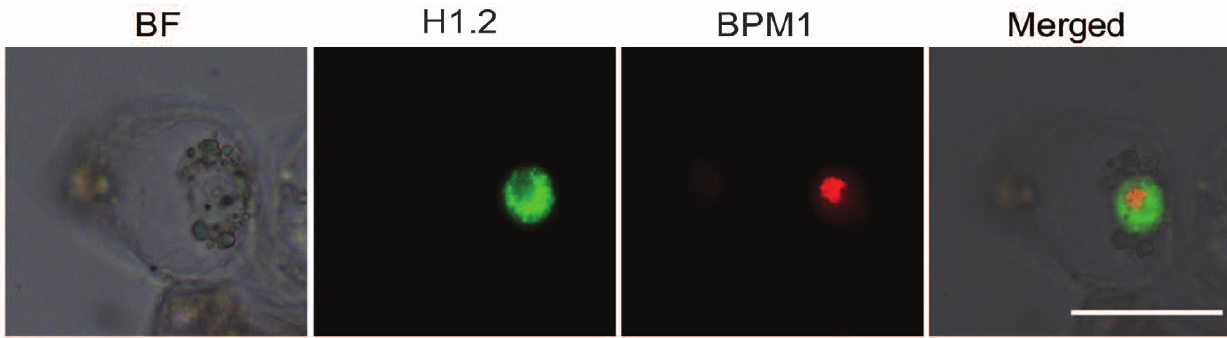
Figure 2. Subcellular co-localization of histone H1.2 (Egfp:H1.2) and BPM1 (RFP:BPM1) in the tobacco BY2 cells. The BPM1 predominantly forms agglomerates in the nucleolus. BF: bright field. Bar is 50 m